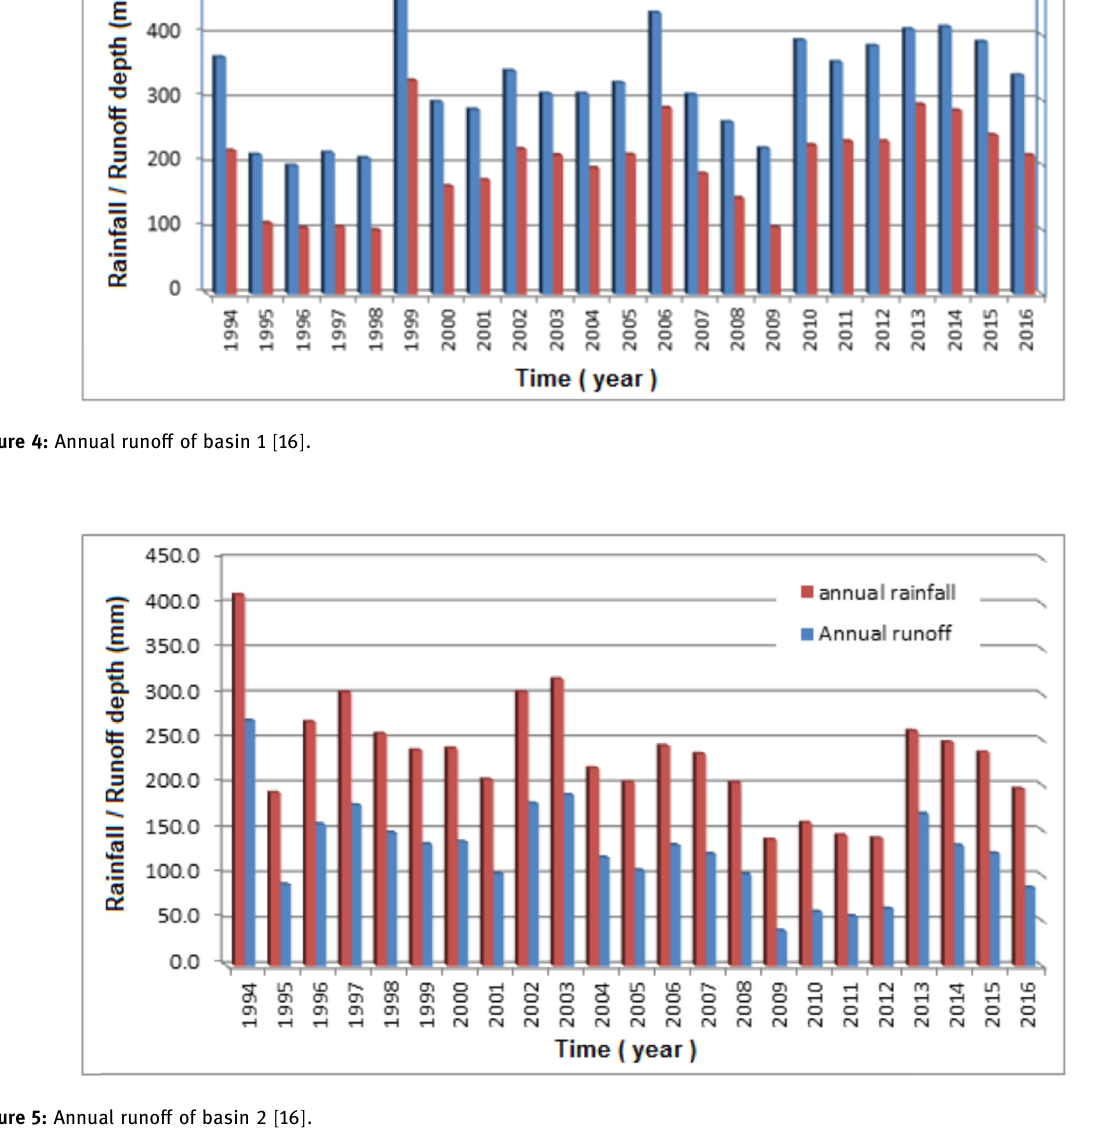
Figure 5: Annual runo ff of basin 2 [ 16 ]